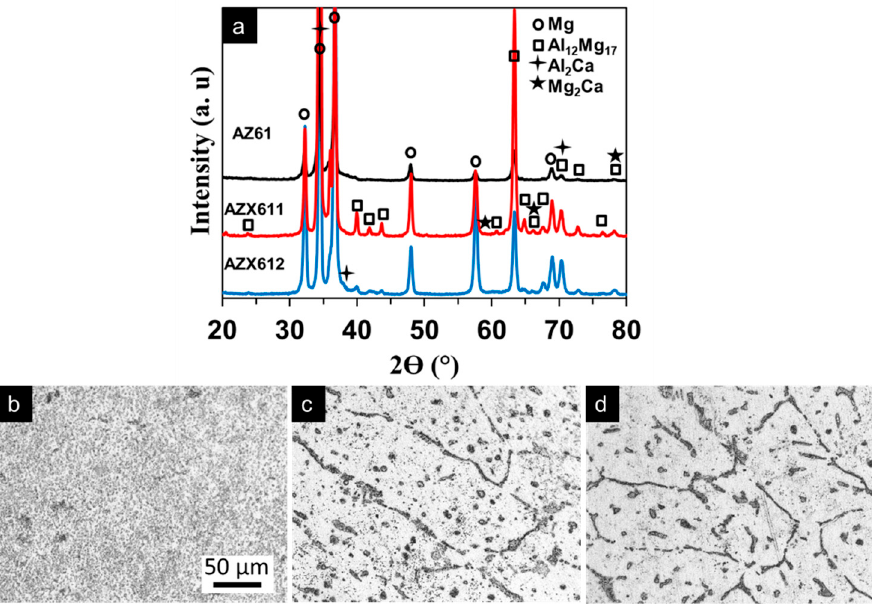
Figure 1. (a ) X-ray diffraction pattern and surface microstructure of ( b ) AZ61, ( c ) AZX611, and ( d ) AZX612 alloys. The scale bar in image (b) applied to images (c) and (d).